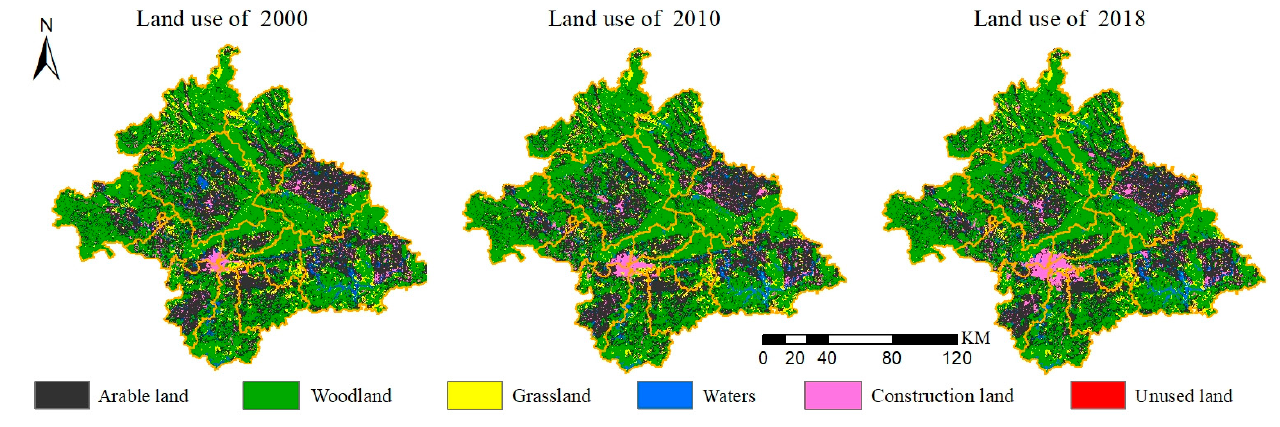
Figure 2. LU of Nanning in different